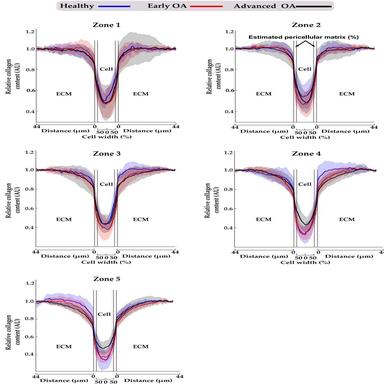
Normalized collagen content profiles of the chondrocyte microenvironment at different tissue depths in the healthy, early OA and advanced OA groups. The lines represent averaged profiles and the shaded regions represent standard deviations within each group.